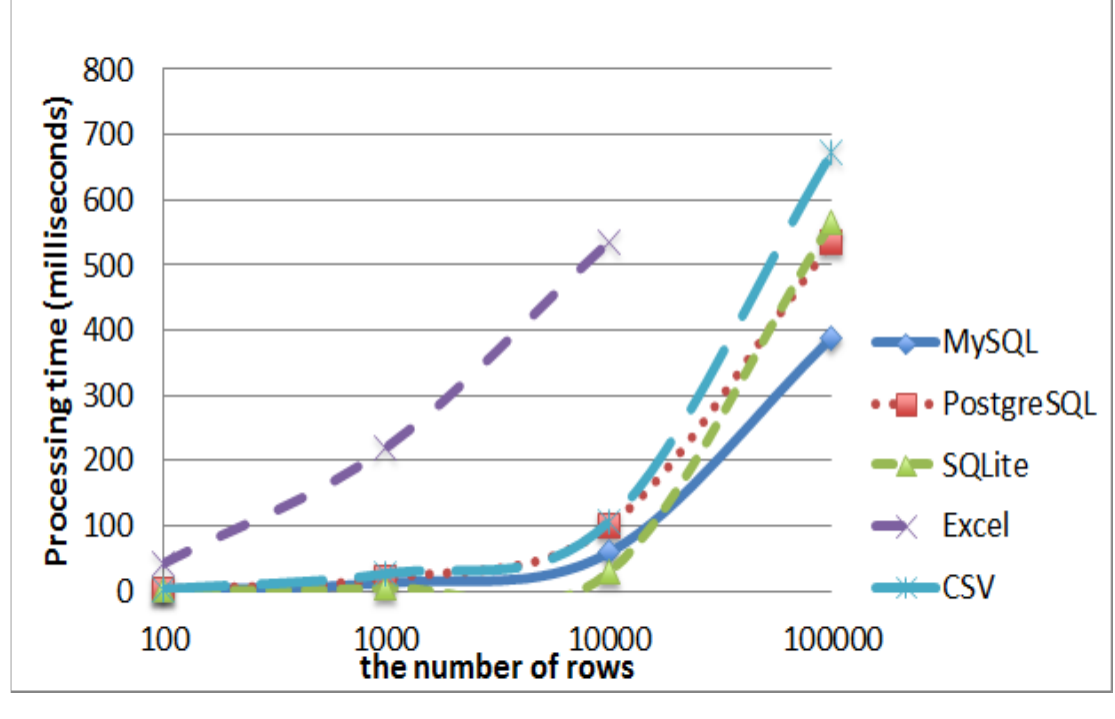
Fig. 7. Data acquisition time.